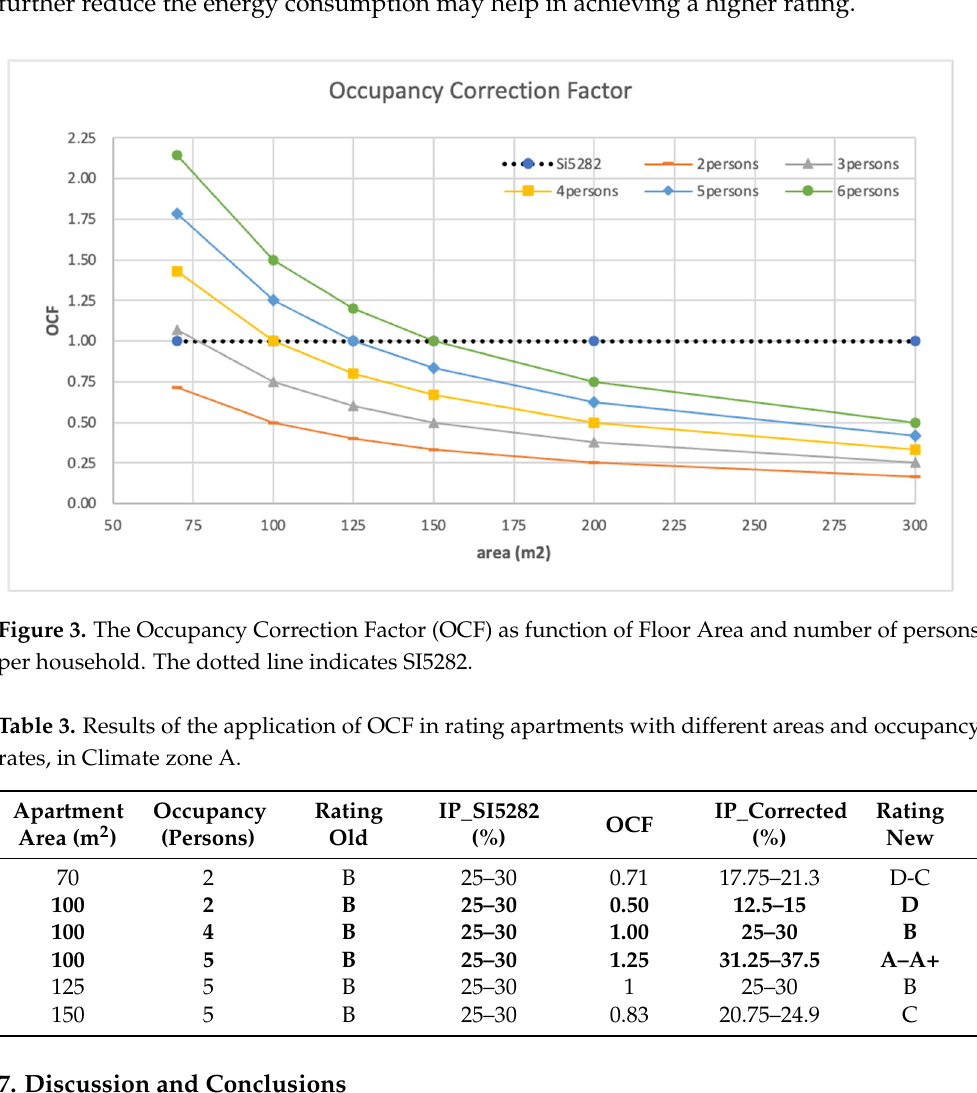
Table 3. Results of the application of OCF in rating apartments with different areas and occupancy rates, in Climate zone A.